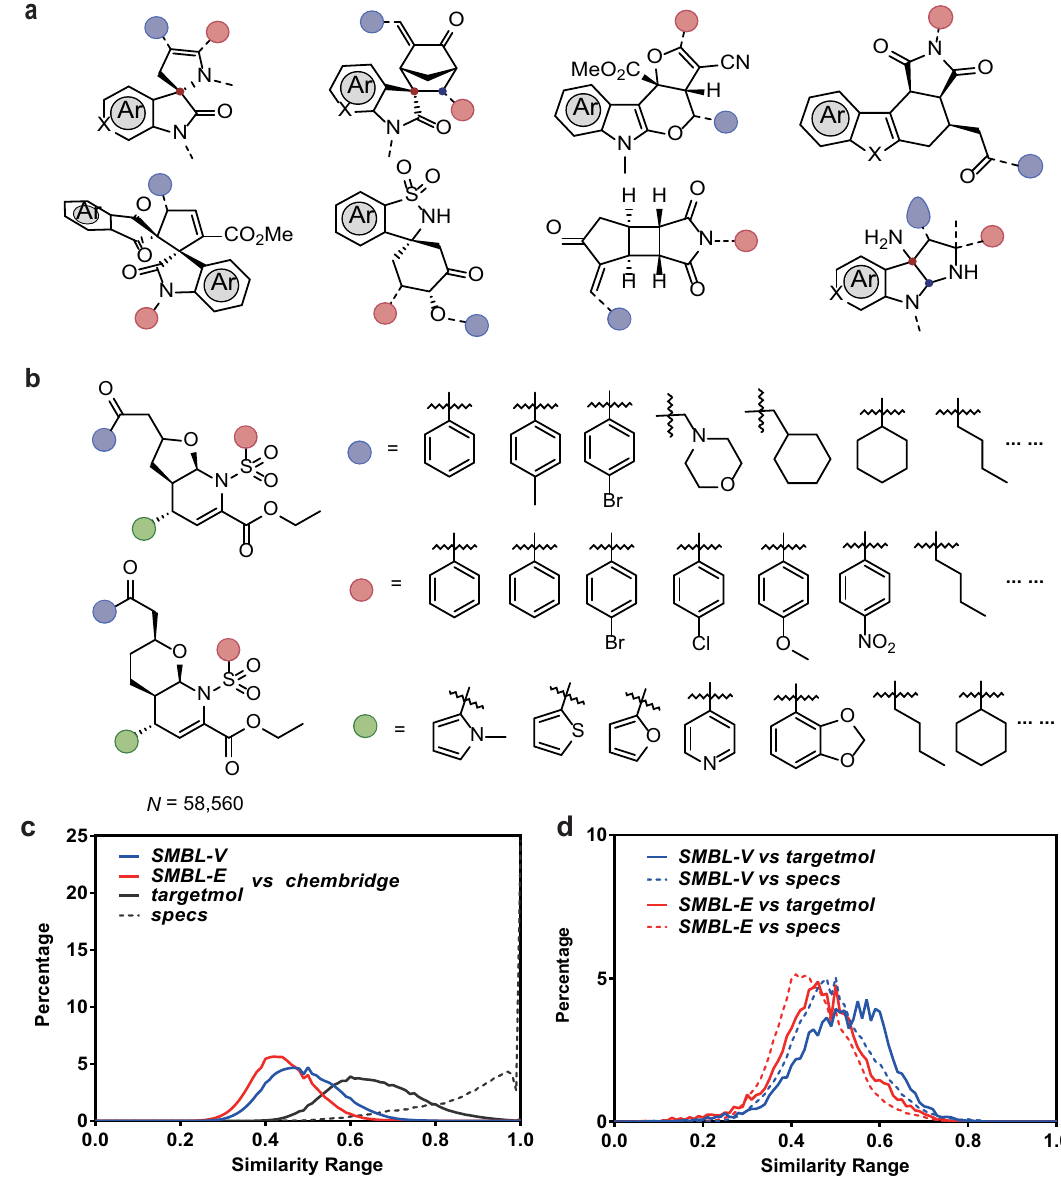
Fig.1|ConstructionandanalysisofSMBL.a Representativescaffoldoftheentity library. The spheres show different substituents. b Derivation of the existing compoundstoconstructthevirtuallibrary.Twocompoundsfromonepaper(